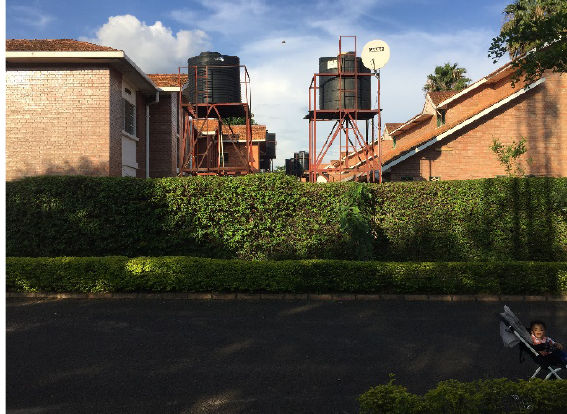
Figure 43. Backyards in between rows. Photograph by Manlio